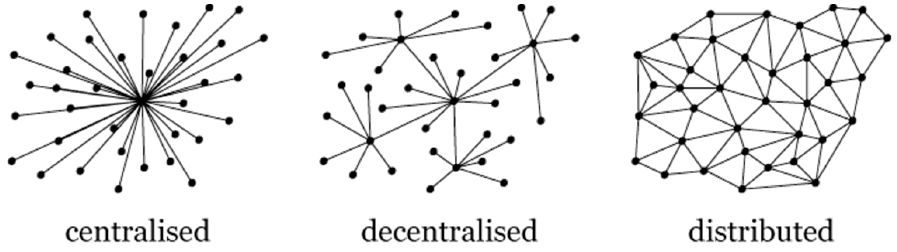
Figure 3. Network architectures, own illustration following [17].